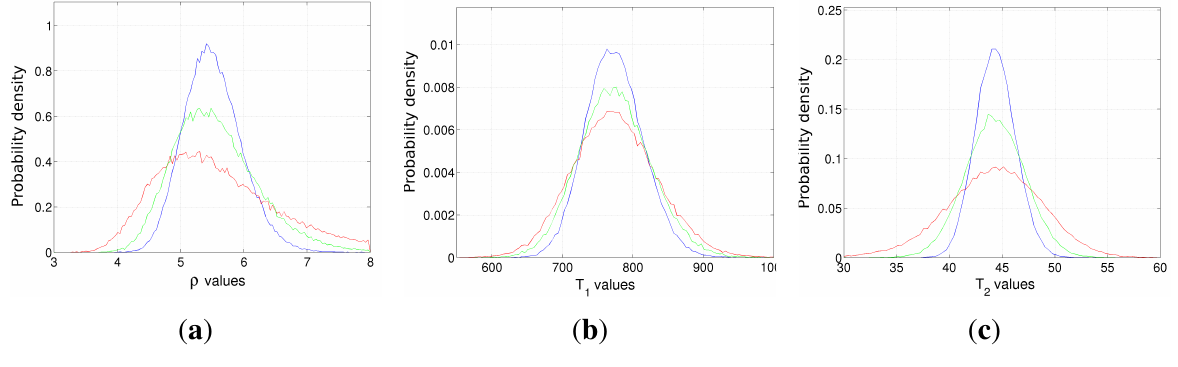
( b ) and T ( c ) estimators 1 2